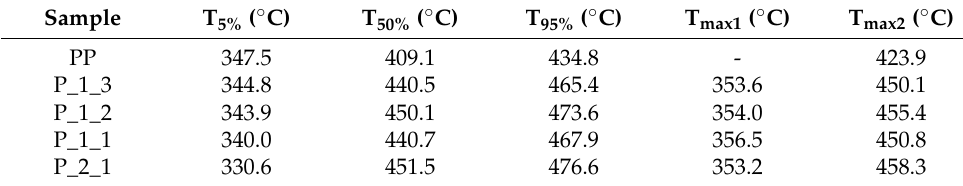
Table 4. The results of the thermogravimetric analysis (TG) of individual